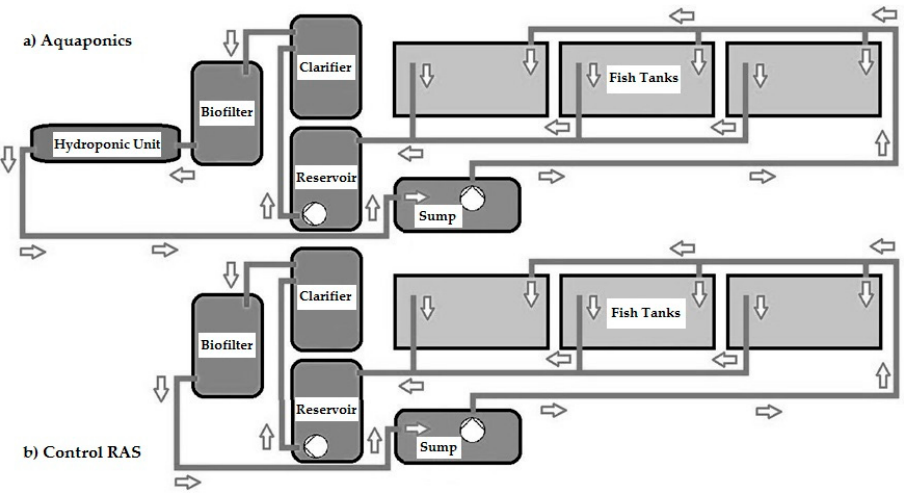
Figure 1. Schematic arrangement and water flow of ( a ) aquaponics and ( b ) control recirculating aquaculture system (RAS).